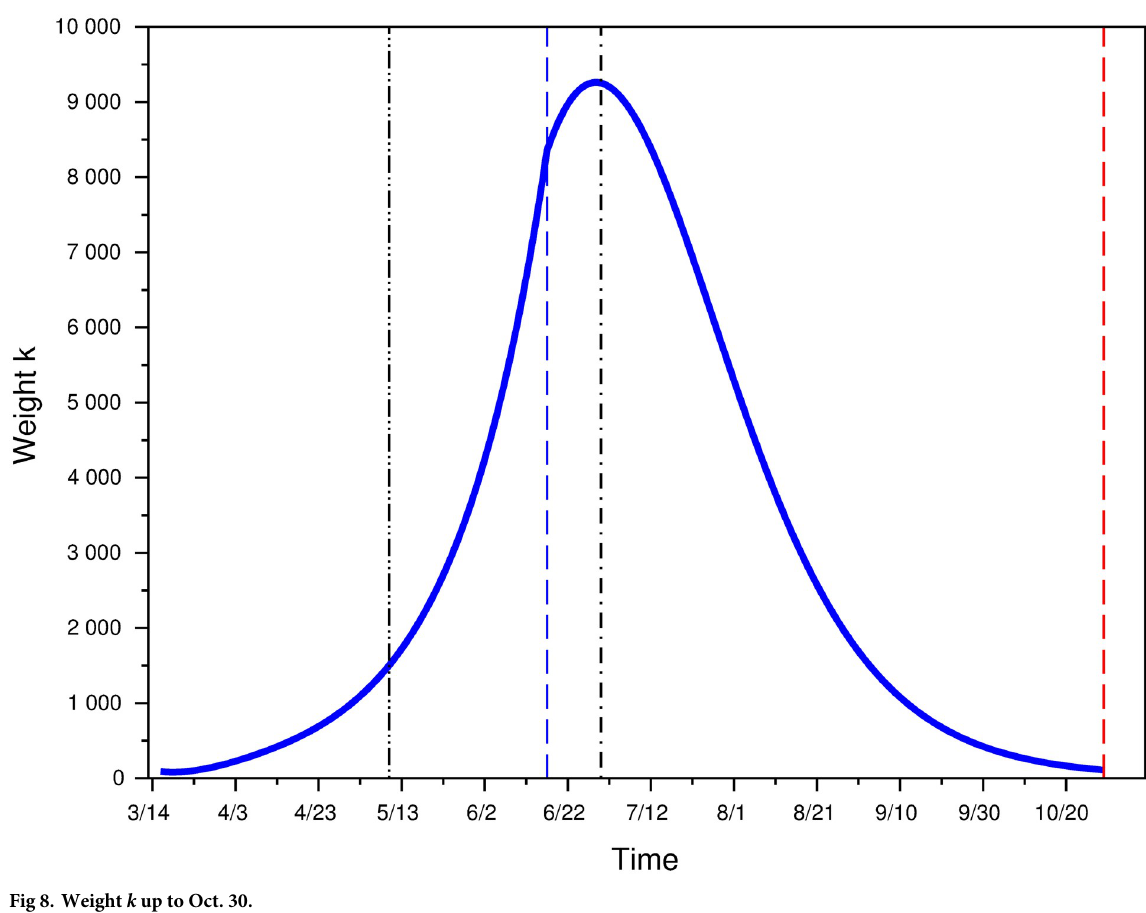
Fig 8. Weight k up to Oct.